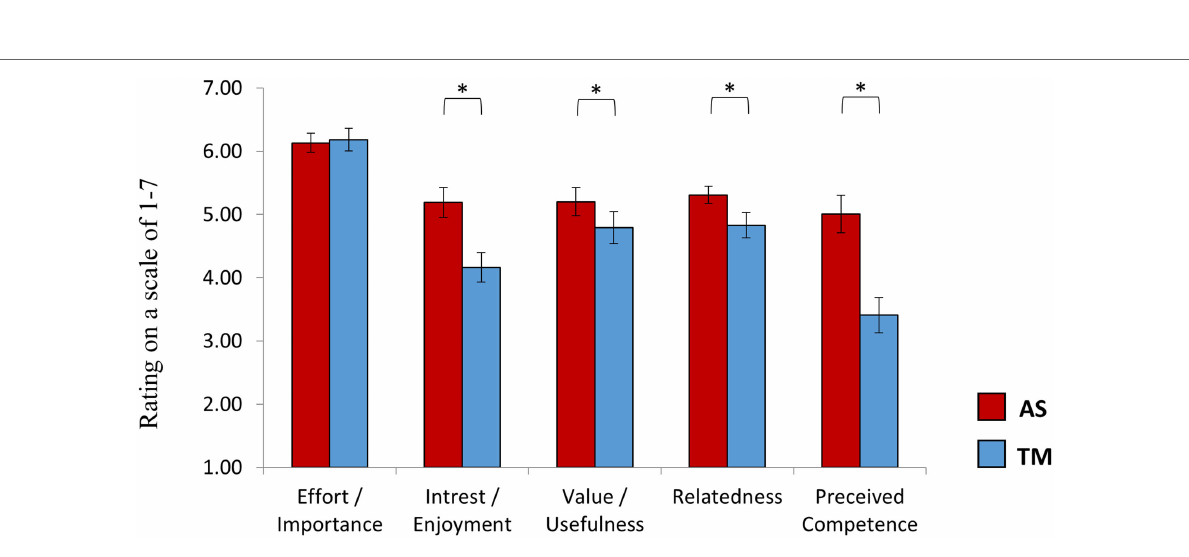
FigUre 6 | intrinsic motivation inventory (eMi) . At the end of session 2, after practicing NF both with the TM and the AS, participants rated the learning experience induced by each interface. While participants reported that it was equally important for them to succeed with both interfaces, the AS interface was reported more enjoyable and as providing a feedback to which participants could more easily relate. Furthermore, participants reported that they felt more competent following training with the AS interface relative to the TM interface. The interface assigned at the first session had no influence on individual ratings. * p (Bonferroni) < 0.05.